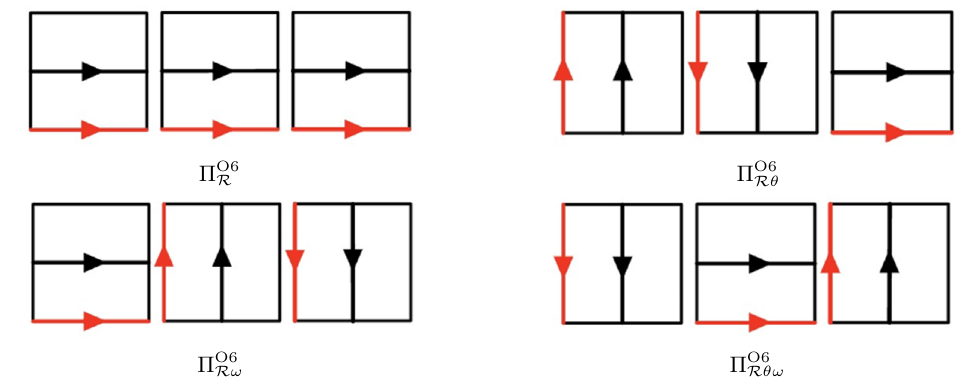
Figure 2. D6-brane configuration leading to (3.19). In red are the O6-planes with D6-branes on top of them.